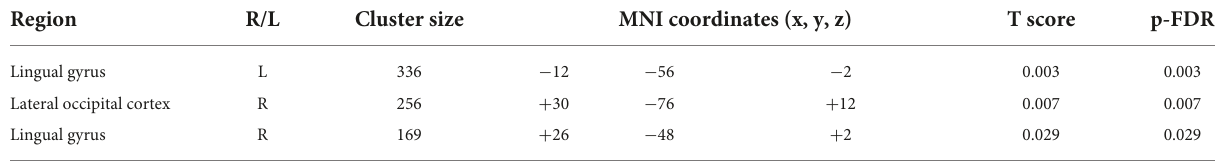
TABLE 3 Seed-to-voxel analysis showing greater functional connectivity in PIGD patients than in TD patients. Region R/L Cluster size MNI coordinates (x, y, z) T score p-FDR Lingual gyrus L 336 − 12 − 56 − 2 0.003 0.003